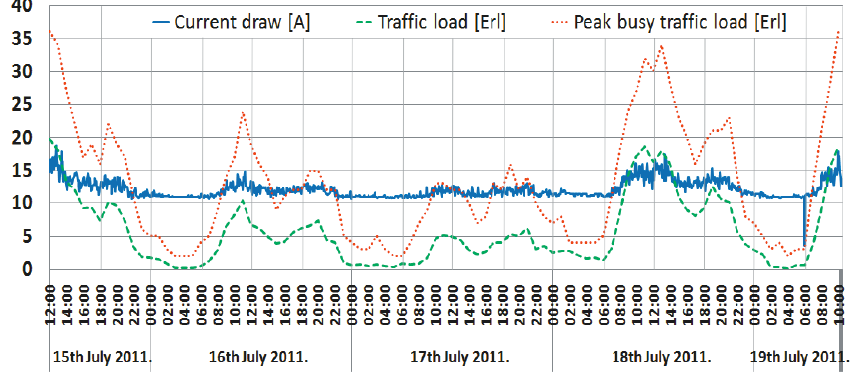
Figure 8. Comparison between electric current draw and traffic load for GSM BS (Sector 1).